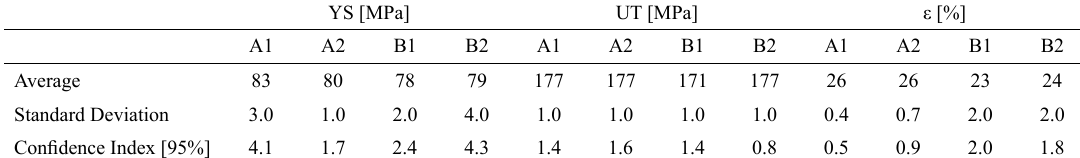
Table 6. Tensile test results (YS – yield strength, UT – ultimate tensile, ε - elongation).